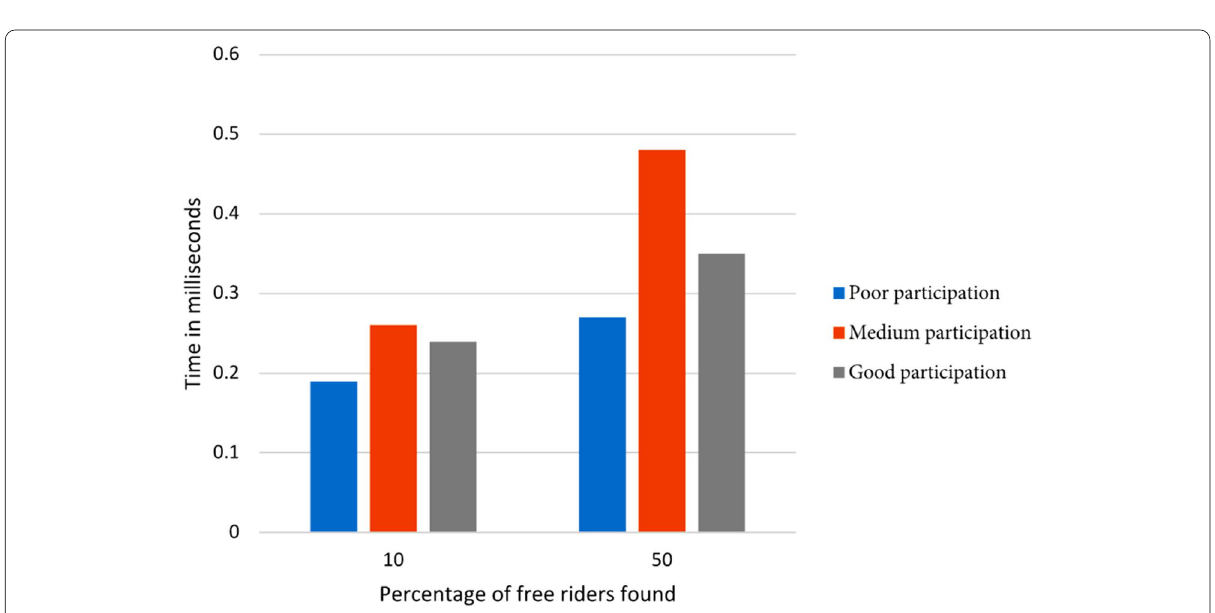
Fig. 6 Percentage of free riders found vs time